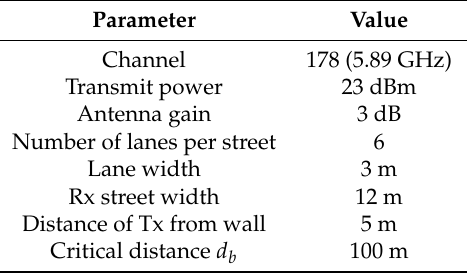
Table 1. Simulation